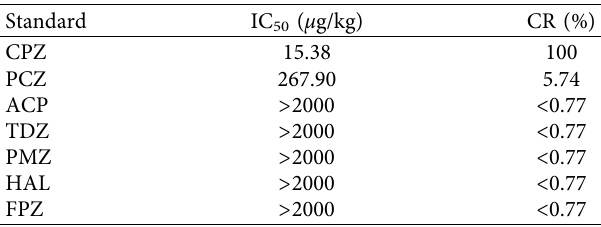
Figure 1: Description of the principle of nanosphere-based time-resolved fluorescence immunoassay (nano-TRFIA). NC: nitrocellulose; PVC: polyvinyl chloride; CPZ: chlorpromazine. Table 1: CR of mouse anti-CPZ monoclonal